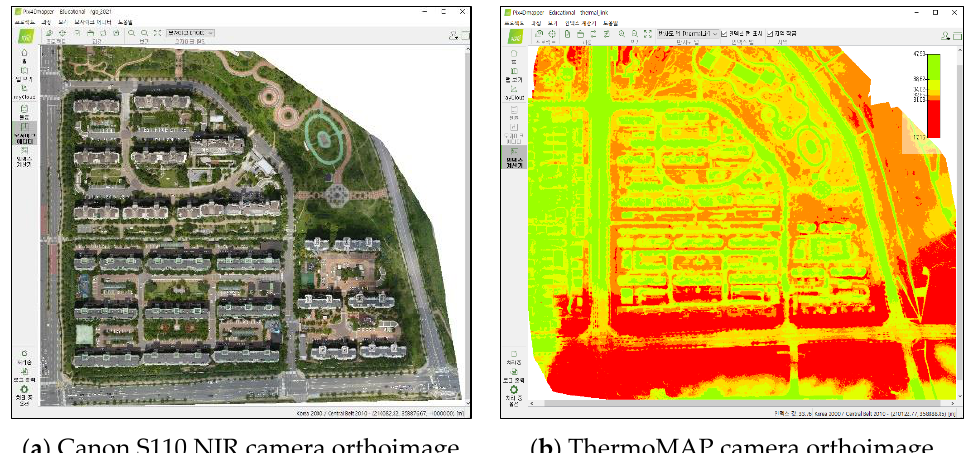
Figure 6. Number of images taken by each camera.